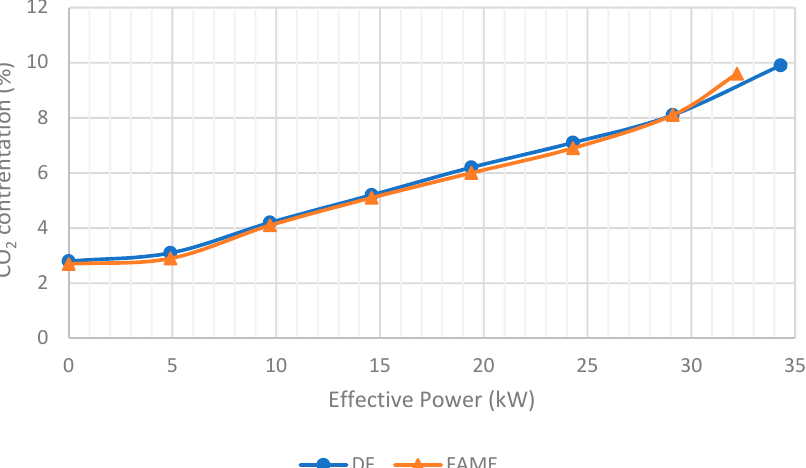
Figure 7. CO 2 emission level in the exhaust gas as a function of the effective power of the S-4003 engine, at an engine speed of 2200 rpm.